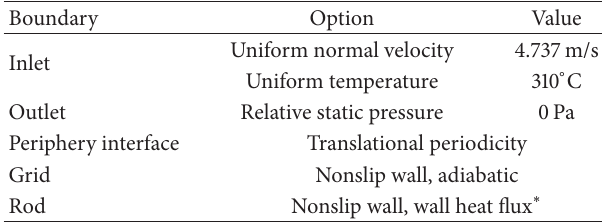
Table 1: Projected areas of a mixing vane and a guide tap. Table 2: Boundary